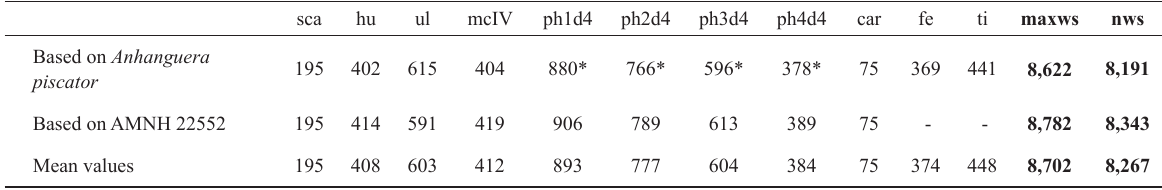
Estimated lengths (in mm) of the forelimb and hind limb elements of Tropeognathus cf. T. mesembrinus (MN 6594-V) based on the bone ratios of Anhanguera piscator (NSM-PV 19892) and AMNH 22552 (Table 2). The length of scapula and carpals were kept constant since they were measured directly on the specimen. Abbreviations: car - carpals, fe - femur, hu - humerus, maxws - maximized wingspan, mcIV - metacarpal IV, nws - normal wingspan, ph1d4 - phalanx 1